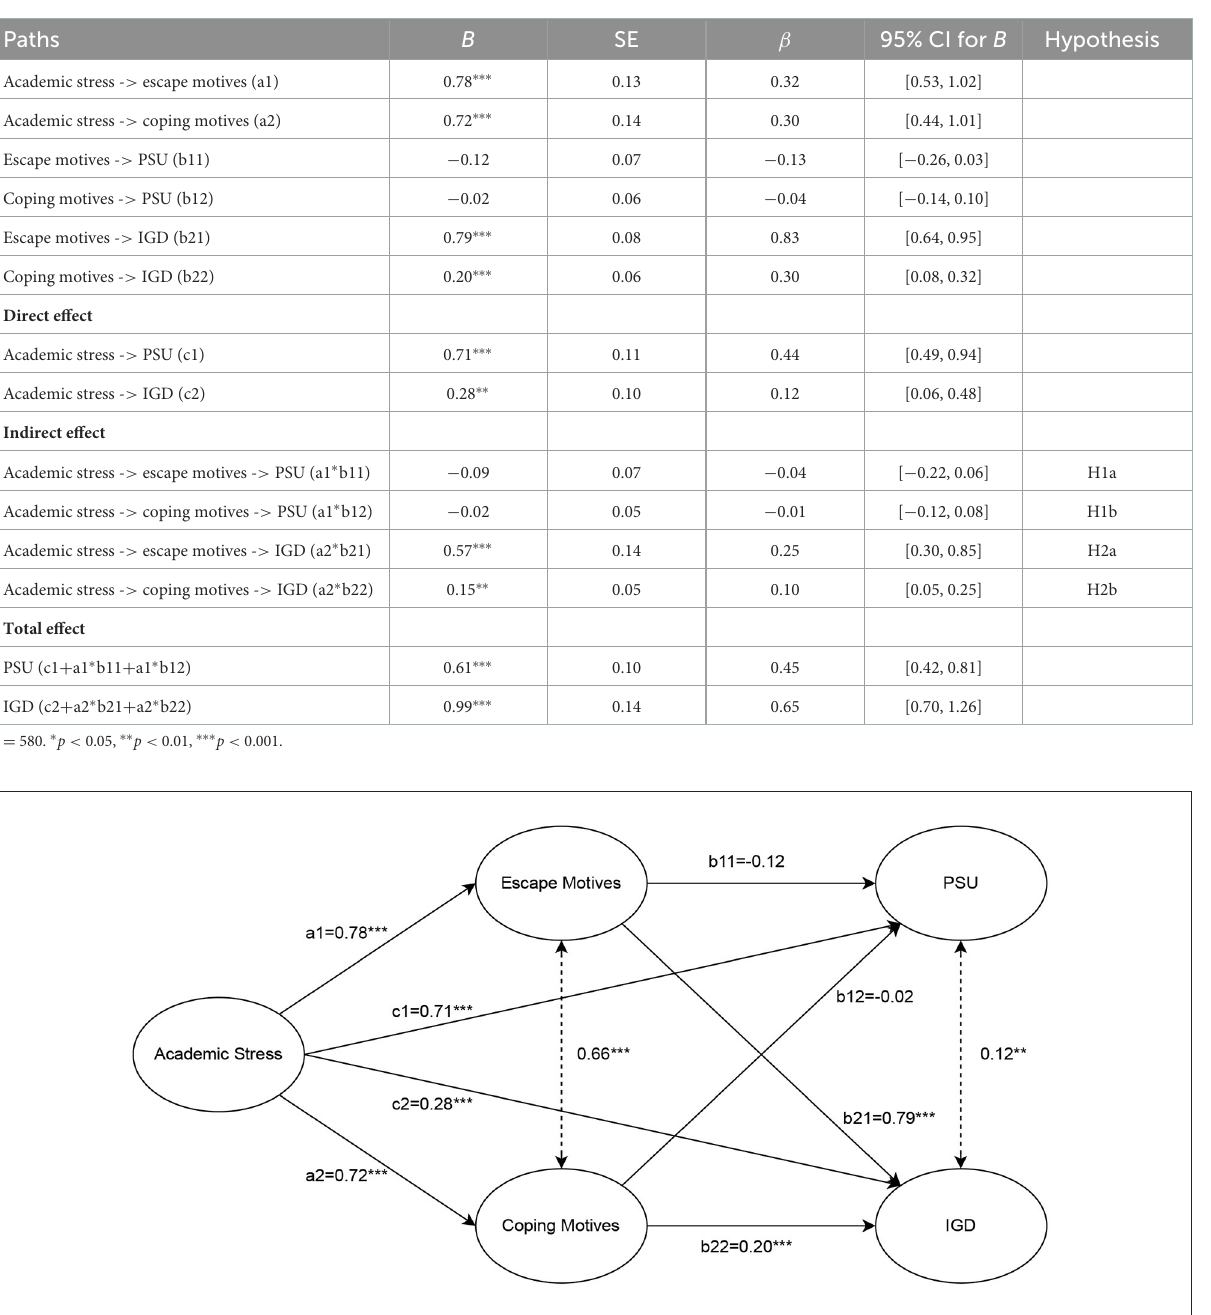
TABLE 8 Results of mediational analysis.